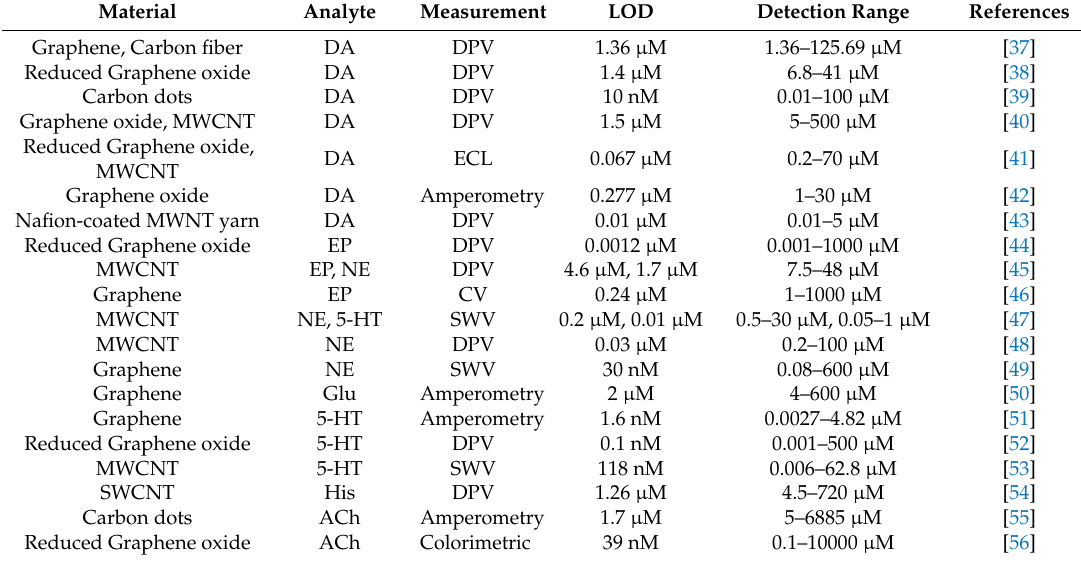
Table 1. Carbon based sensor for neurotransmitter